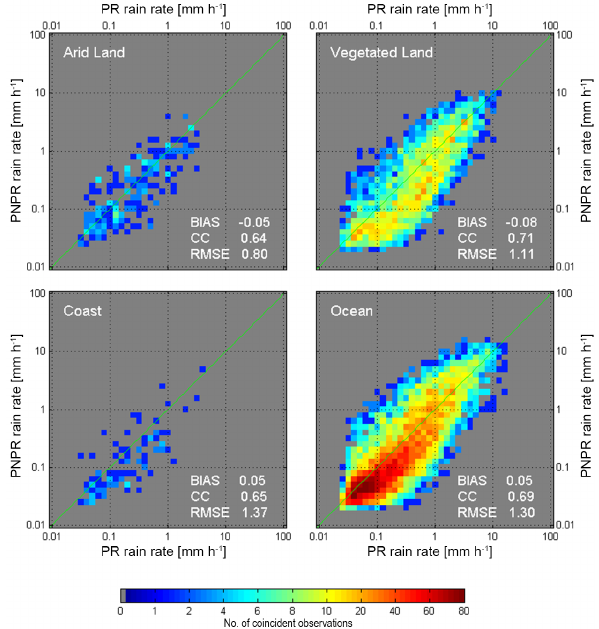
Figure 5. Density scatter plots of the PNPR v2 and TRMM-PR mean rainfall rates (over a 0.5 ◦ × 0.5 ◦ regular grid, for the period 2013–2014) for the African area for different surface types. A log- arithmic scale is used for the precipitation rates in mmh − 1